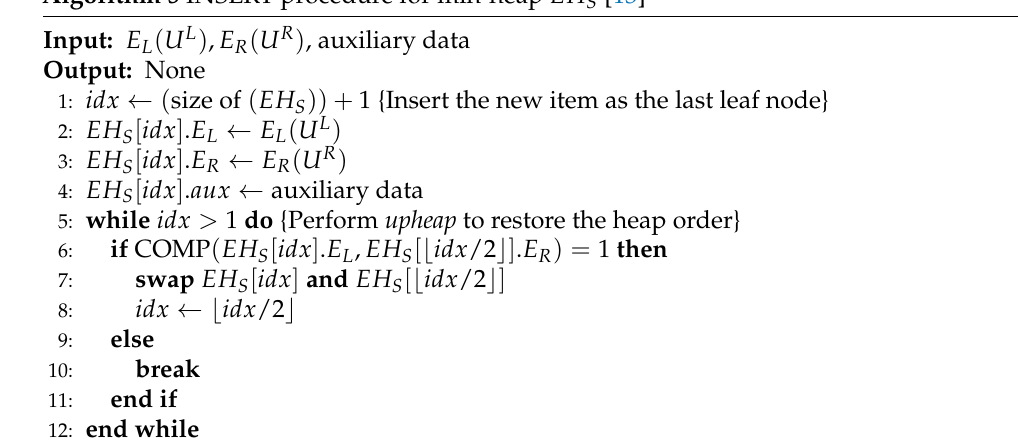
Algorithm 5 INSERT procedure for min-heap EH S